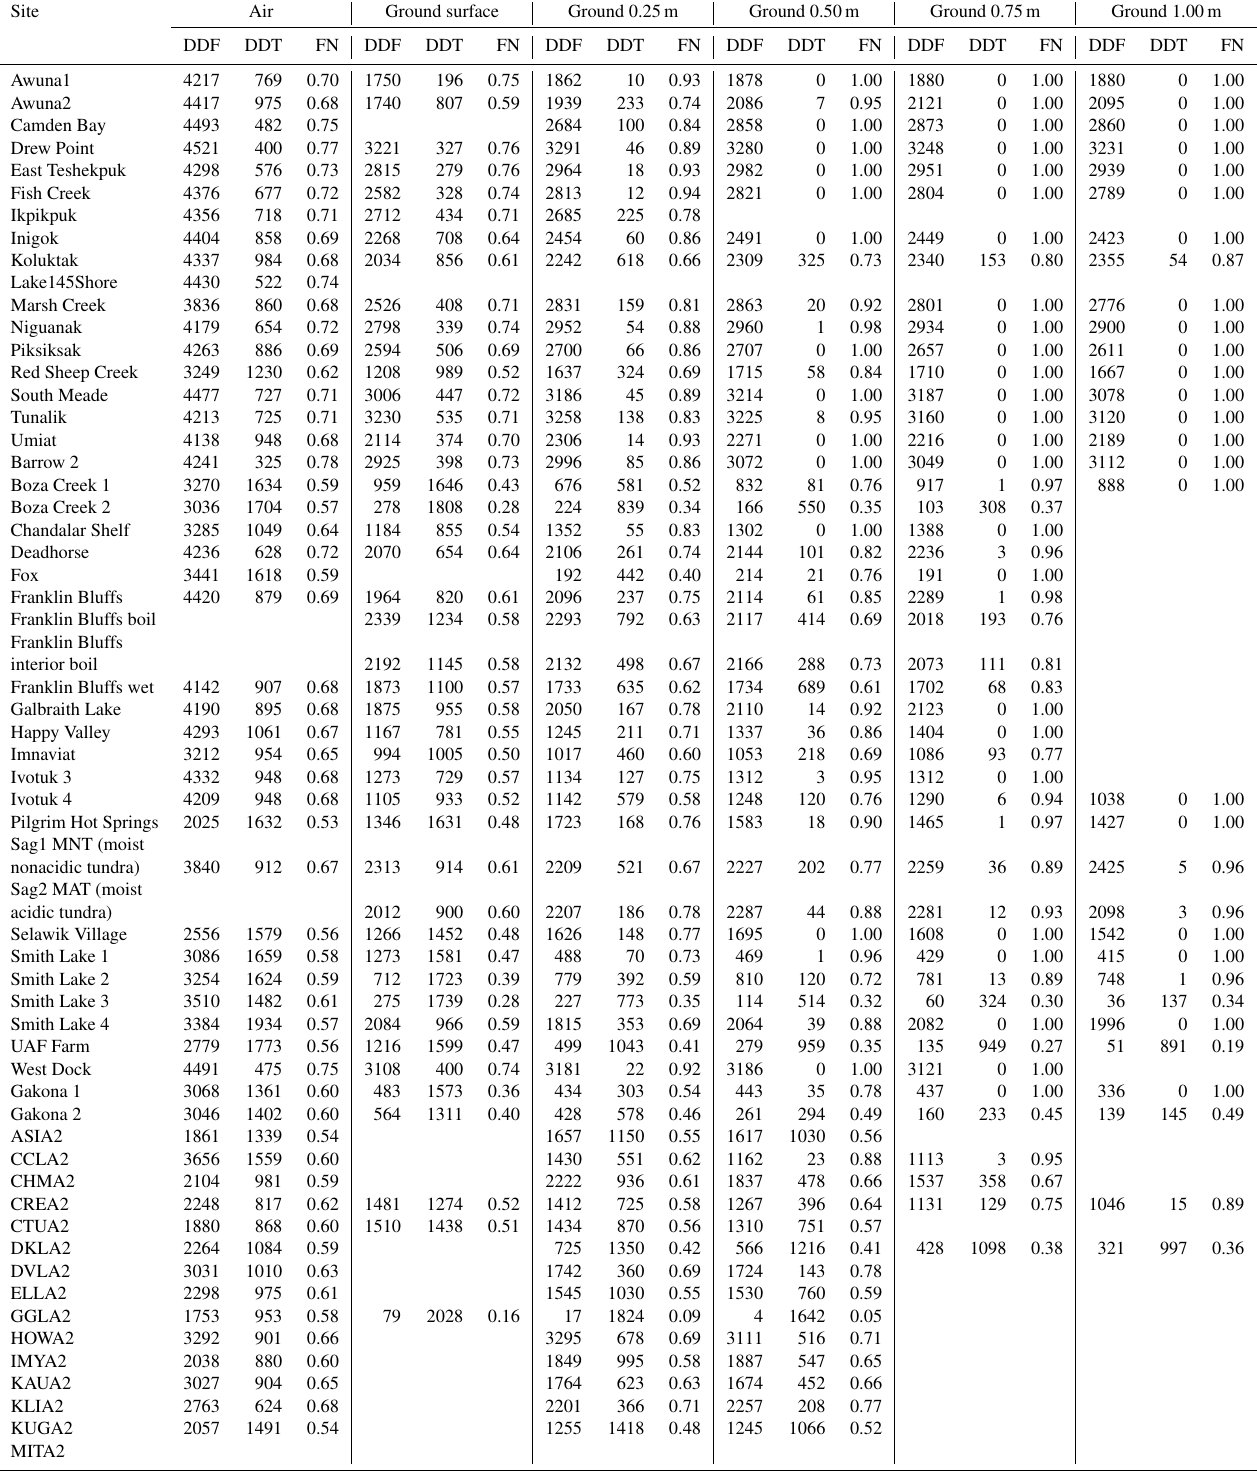
Table 5. Summary of freezing index (DDF, ◦ C days), thawing index (DDT, ◦ C days), and frost number (FN, unitless) of air and ground temperatures over the entire observation